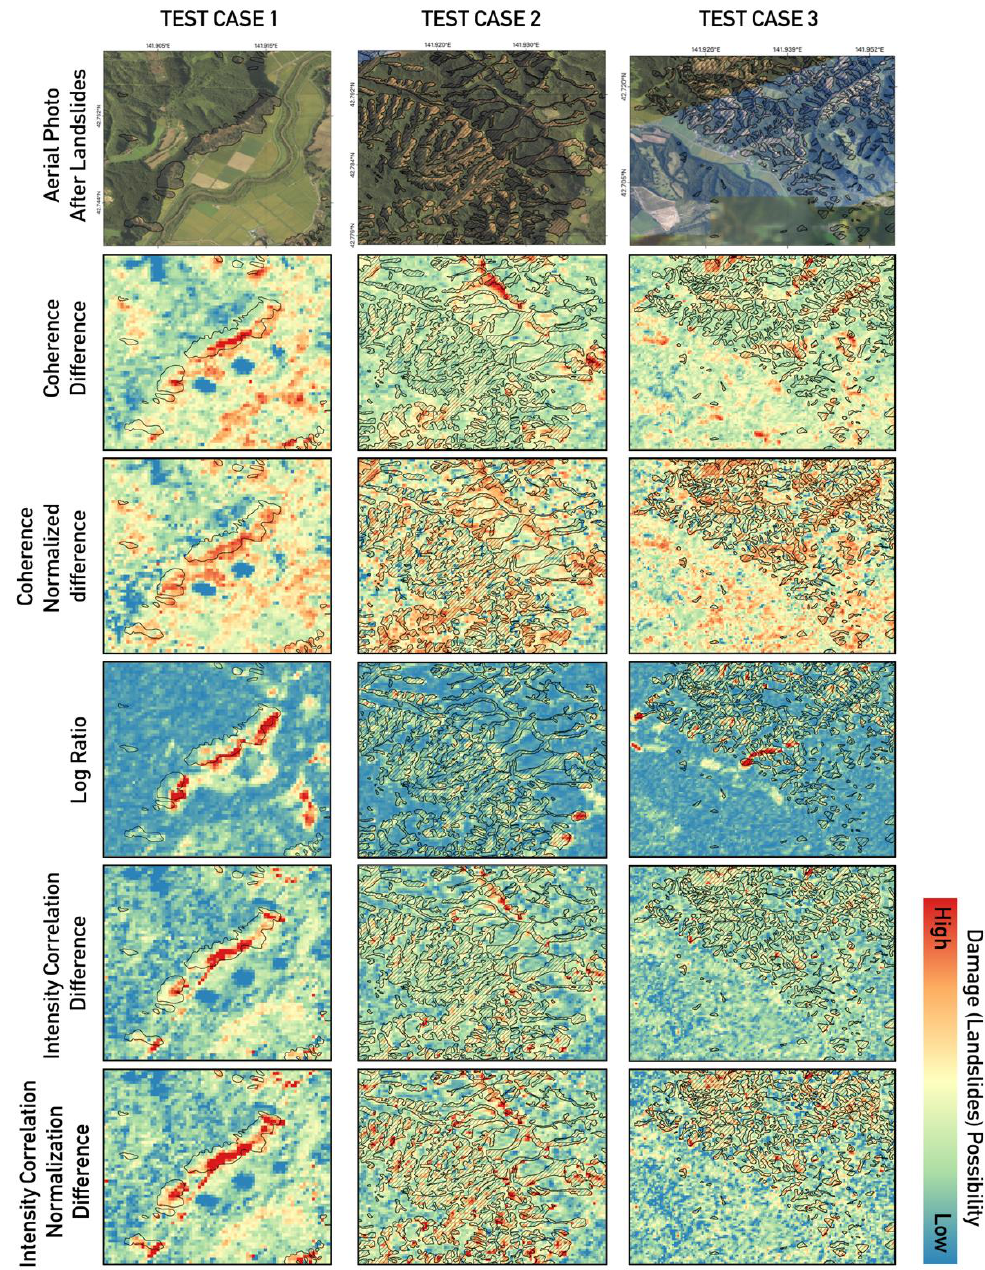
Figure 6. Results of damage (landslides) detection algorithms for quick-product analysis (scenario assuming limited availability of data). Test case 1 (left column) consists of houses and crop areas. Test cases 2 (middle column) is mainly covered by forest. Test cases 3 (right column) has crops and forest area. All images are rescaled to the range 0 to 1 for visualization. Red color indicates the high possibility (or large difference from reference product) of event-induced changes (landslides). Black polygons depict the landslide area extracted from aerial photos.